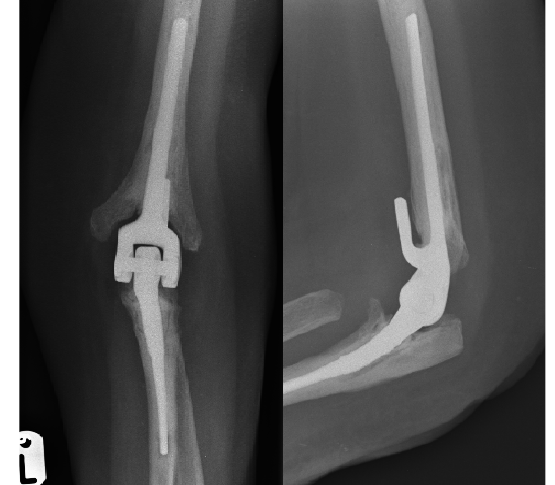
Figure 2 : Total elbow replacement.